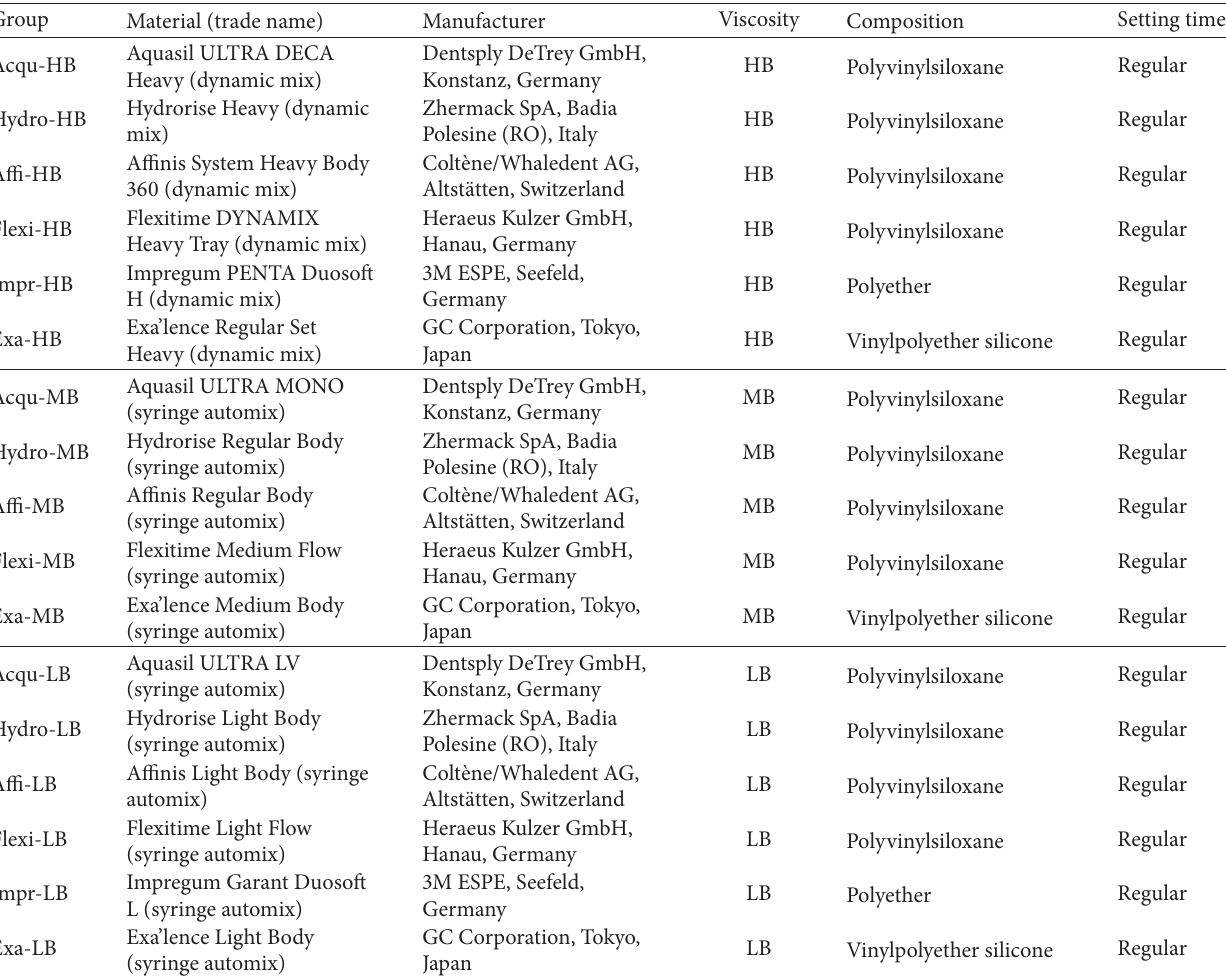
Table 1: Information on the materials tested.